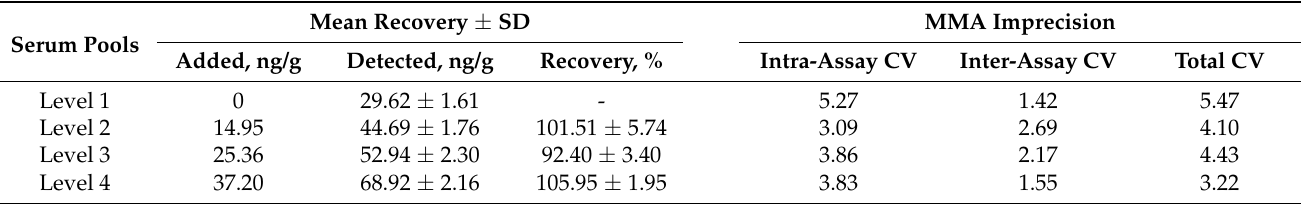
Table 2. Spiked recovery and precision performance of the LC-MS/MS method for methylmalonic acid quantification.